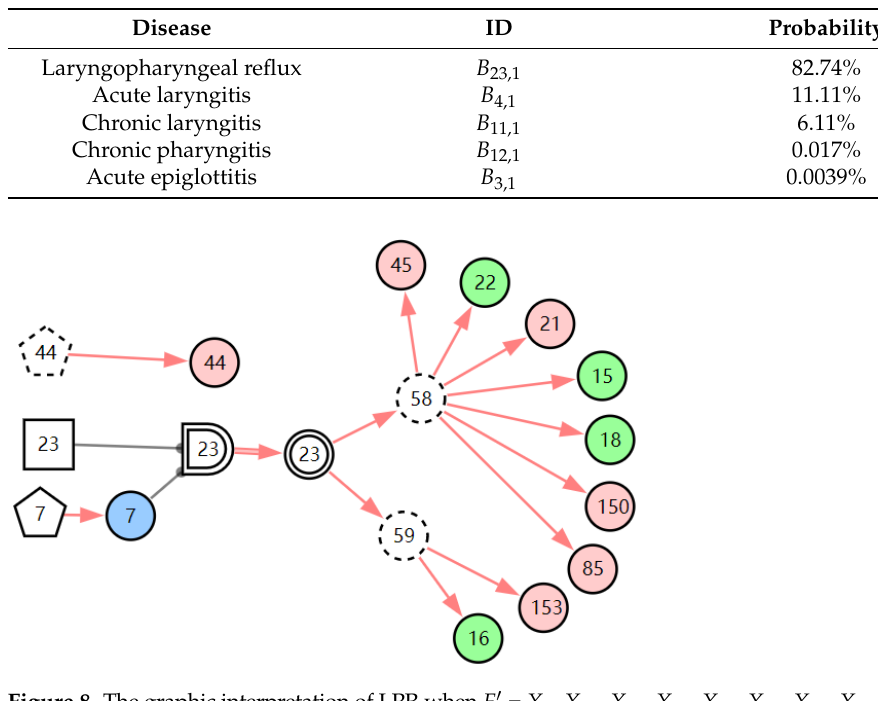
Figure 8. The graphic interpretation of LPR when E ’ = X 7,4 X 52,1 X 85,1 X 21,1 X 15,1 X 45,1 X 44,1 X 150,1 X 5,1 X 153,1 .